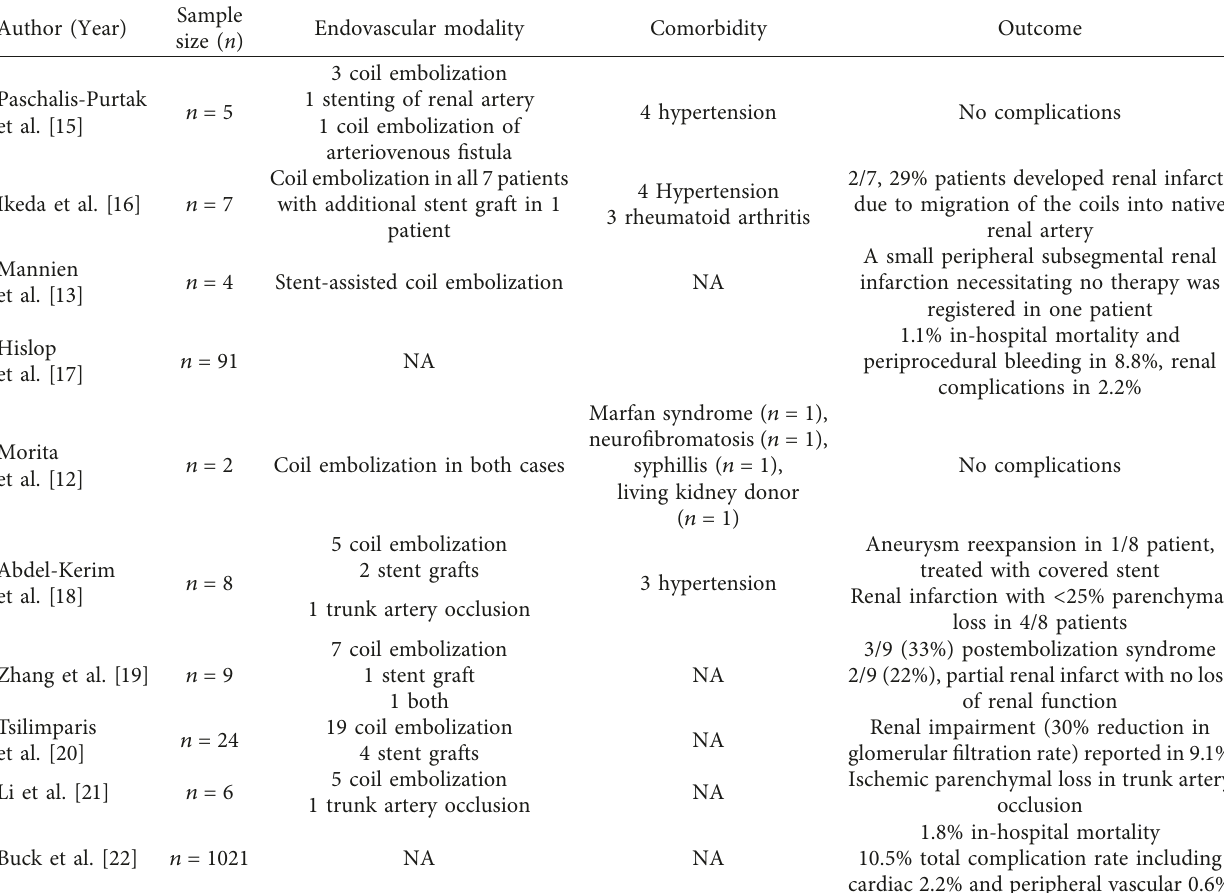
Table 1: Summary of the